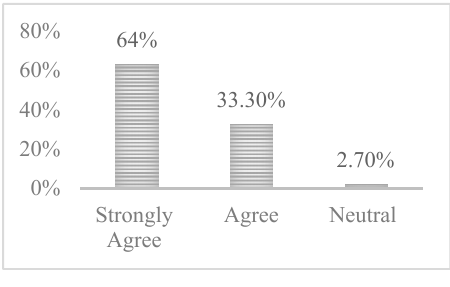
Figure 4. FoMO-R clarity.